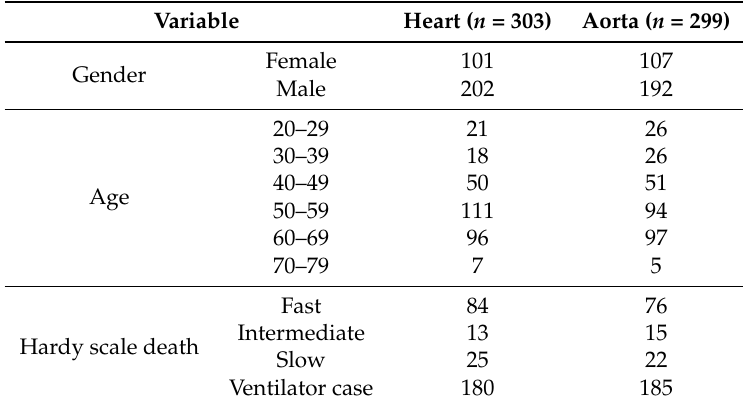
Figure 2. Evidence of protein-protein interaction in cardiovascular tissues. ( A ) Network interactivity of the genes of HSP70-family, TLR4 and MD2. Nodes are colored according to the community determined by the Louvain modularity algorithm. ( B ) Pearson ρ correlation matrix of HSP70-family with TLR4 and MD2 transcriptome expression levels of heart (left ventricle) and aortic human tissues plotted in a red (positive correlation), white (no correlation), and blue (negative correlation). ( C , D ) Scatter plots of the relationship between expression values in heart (left ventricle) of HSPA13 with MD2, and TLR4 respectively, as well as Pearson ρ correlation coefficient. Table 1. Genotype-Tissue Expression (GTEx) donor profile distribution by gender, age, and hardy scale death in cardiovascular